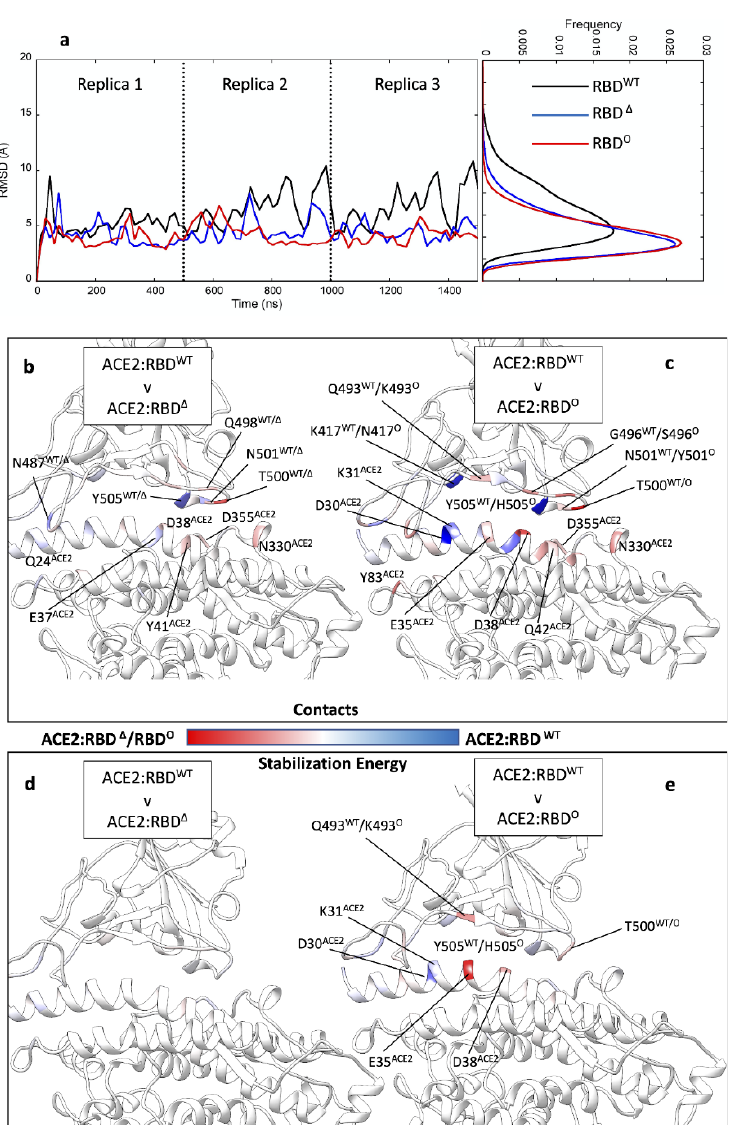
Figure 2. MD of ACE2 in complex with RBD WT , RBD ∆ , and RBD ◦ . ( a ) RMSD of RBD WT , RBD ∆ , and RBD ◦ over the time course of three 500 ns-long replicas (left panel, the curves were smoothed to interpolate the RMSD values) and the relative frequency distribution. ( b ) Comparison between the intermolecular contacts formed in ACE2:RBD WT and ACE2:RBD ∆ complexes; red residues interacted more in ACE2:RBD ∆ , while blue residues were more engaged in ACE2:RBD WT . ( c ) Comparison be- tween the intermolecular contacts formed in ACE2:RBD WT and ACE2:RBD ◦ complexes; red residues interacted more in ACE2:RBD ◦ , while blue residues were more engaged in ACE2:RBD ∆ . ( d ) Compar- ison between the per residue interaction energy in ACE2:RBD WT and ACE2:RBD ∆ complexes; red residues stabilised ACE2:RBD ∆ , while blue residues stabilised more ACE2:RBD ∆ . ( e ) Comparison between the per residue interaction energy in ACE2:RBD WT and ACE2:RBD ◦ complexes; red residues stabilised ACE2:RBD ∆ , while blue residues stabilised more ACE2:RBD ◦